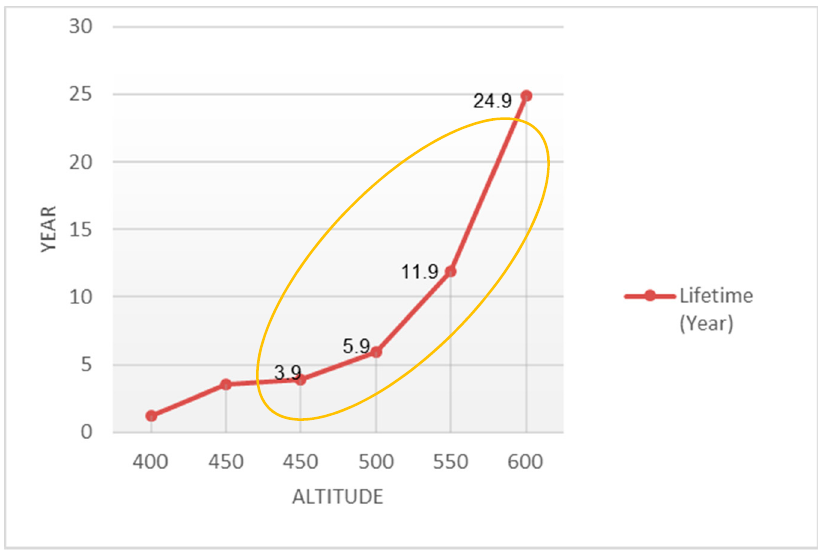
Figure 14. Lifetime analysis of MeznSat [1].